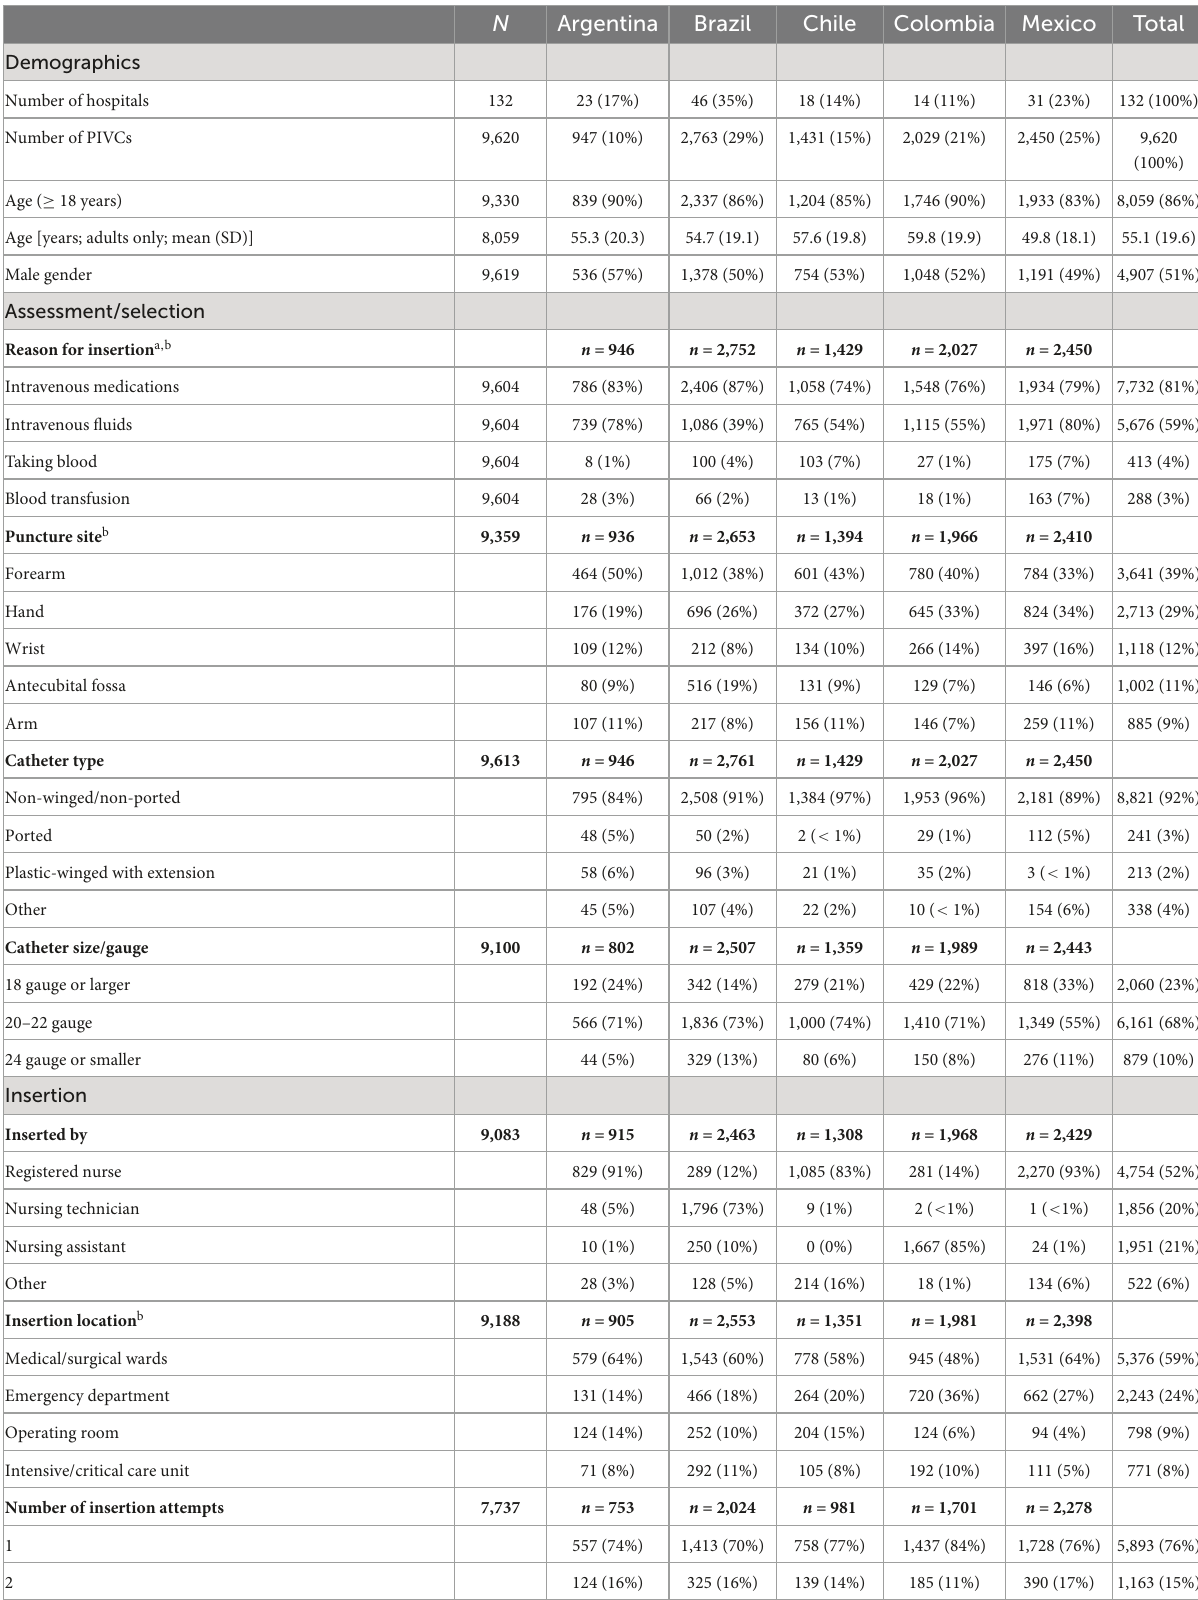
TABLE 2 Peripheral intravenous catheter insertion and assessment characteristics by